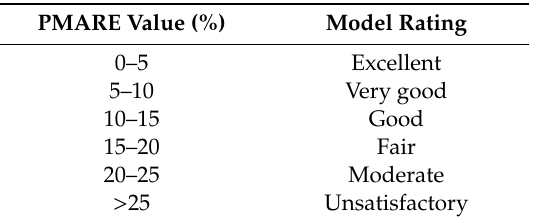
Table 3. Suggested performance rating for model evaluation based on the percent mean absolute relative error (PMARE)